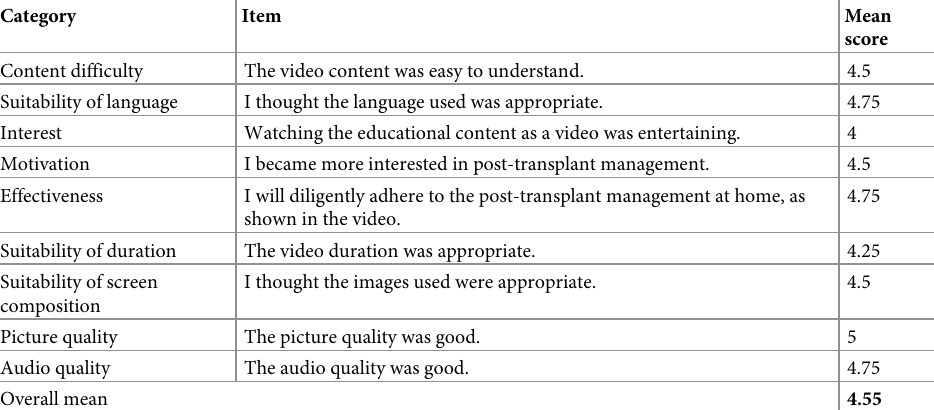
Table 5. Satisfaction assessment for video-based educational materials (N =